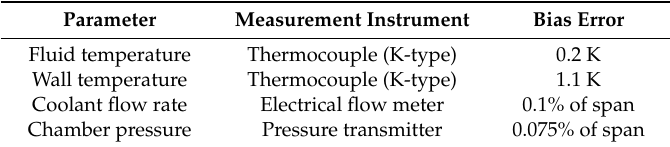
Table 2. Bias error of measurement